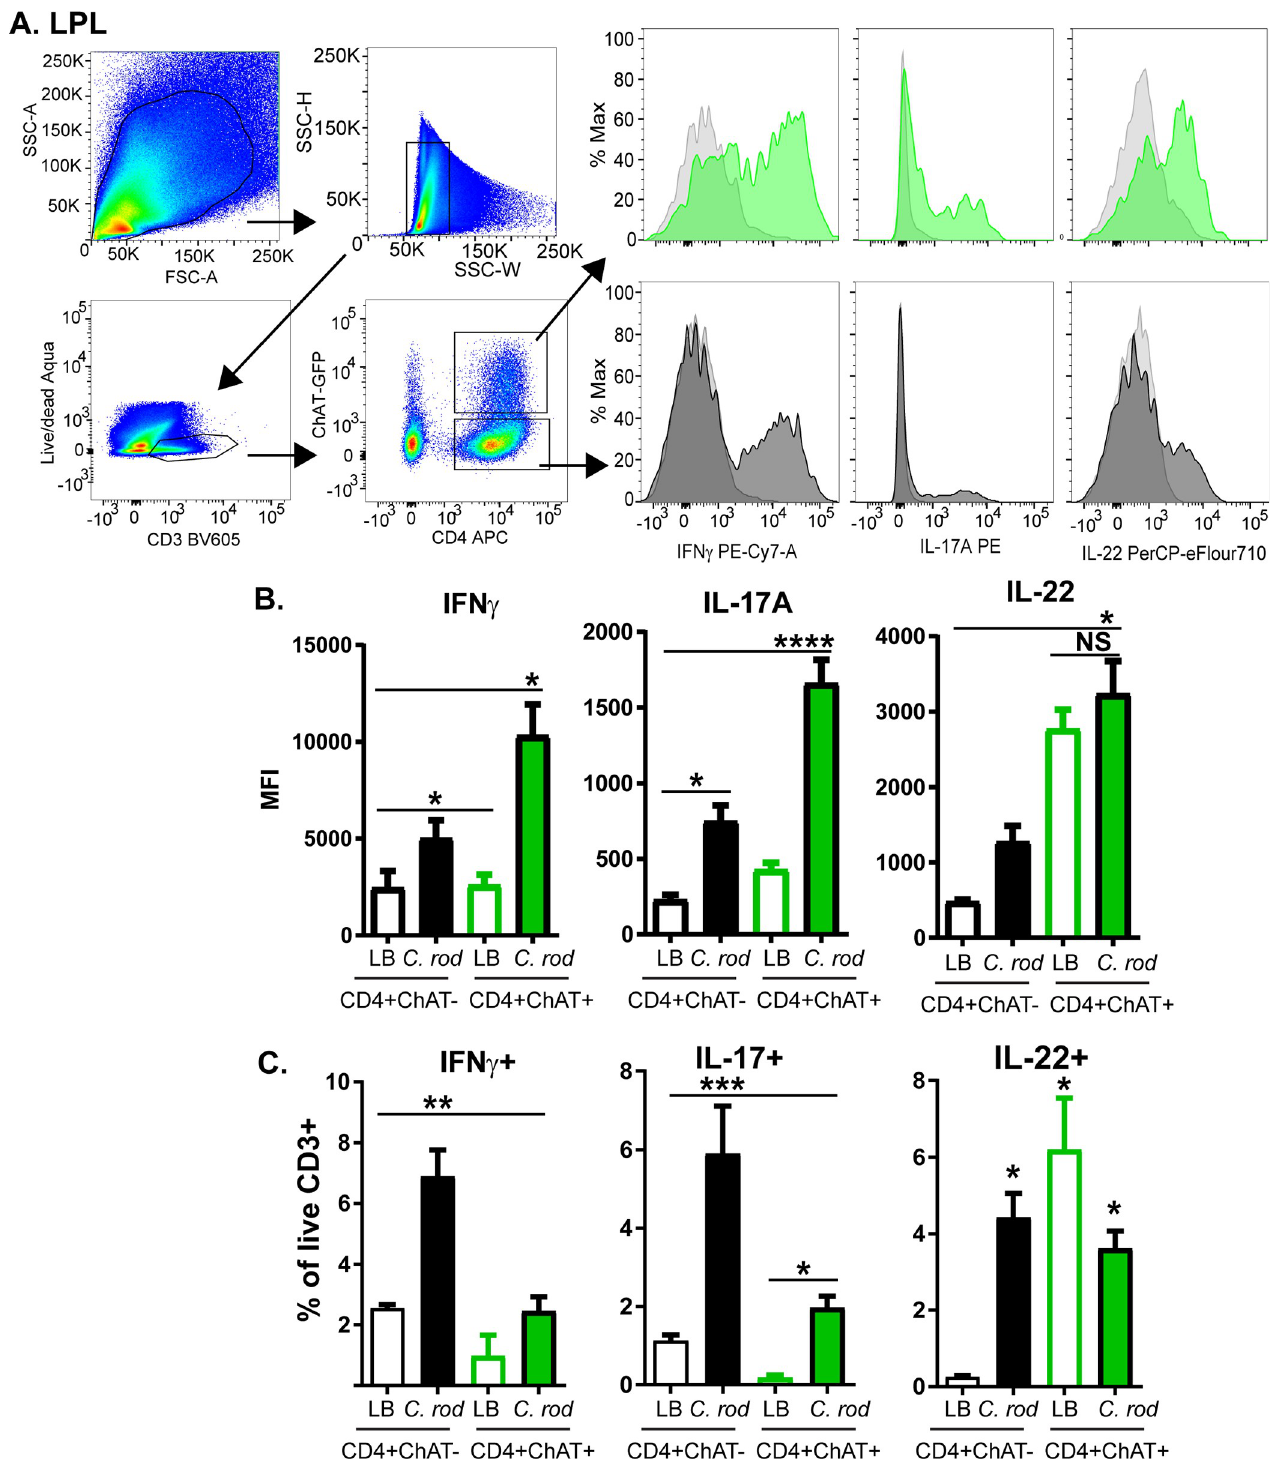
Fig 2. Flow cytometric characterization of ChAT-GFP+ T-cells. (A) Lamina propria lymphocytes were isolated from ChAT-GFP mice 10 days after C. rodentium infection, or (LB gavaged) controls. Representative gating strategy depicts analysis of (lymphocytes, single, cells, live CD3+). CD4+ ChAT-GFP+ or CD4+ ChAT-GFP- cells expressing IFN γ , IL-17A, or IL-22 in each of these populations (light grey: non-stimulated control, green; ChAT-GFP+ cells stimulated with PMA/ionomycin, dark grey: ChAT-GFP- cells stimulated with PMA/ionomycin). The amount of each cytokine was quantified by MFI (B), and the frequency of these cells per live CD3+ cell (C). � P < 0.05 ANOVA, with n = 4–6 mice per group.